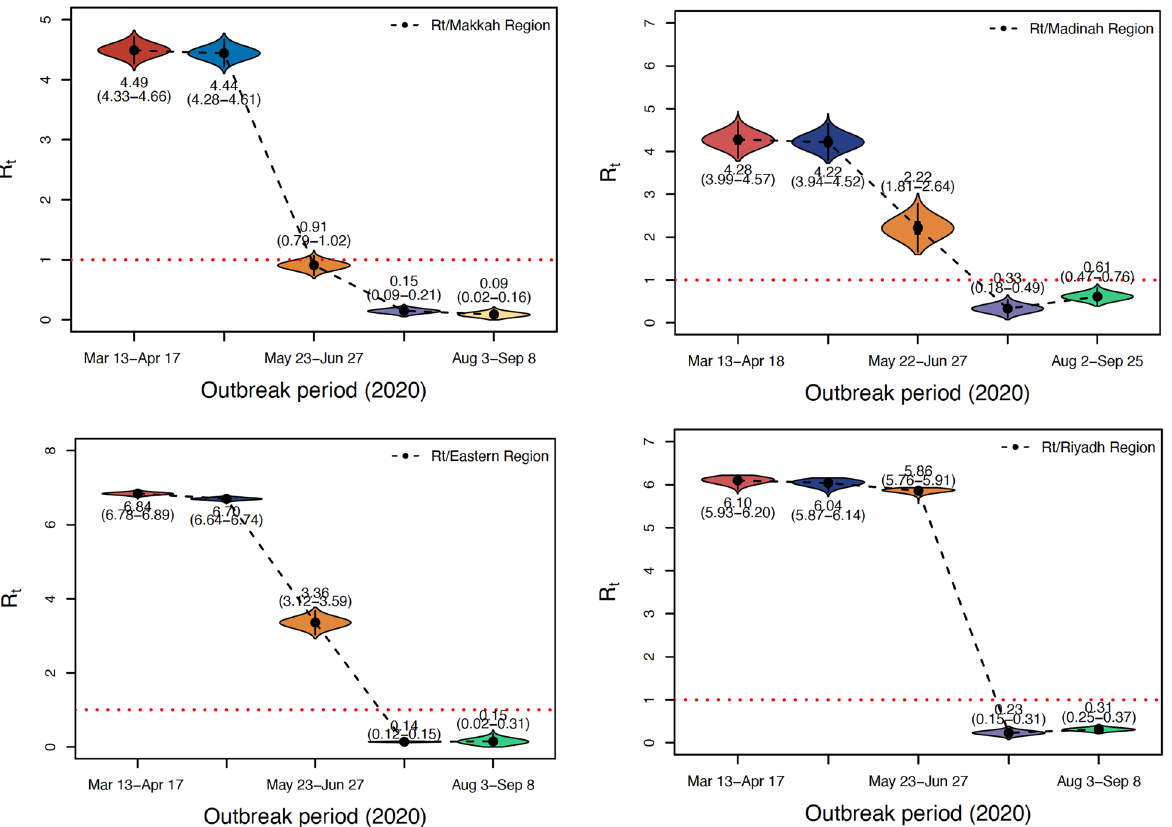
Figure 3. Distribution of Rt estimates derived from 10000 MCMC samples for Makkah, Madinah, Eastern, and Riyadh, respectively. The black dot in the centre of each violin plot denotes the median, the thick bar in the plot denotes the interquartile range, and the thin bar in the plot denotes the lowest and maximum values. The mean and the credible interval for 95%, which is shown in parentheses, are labelled below or above,